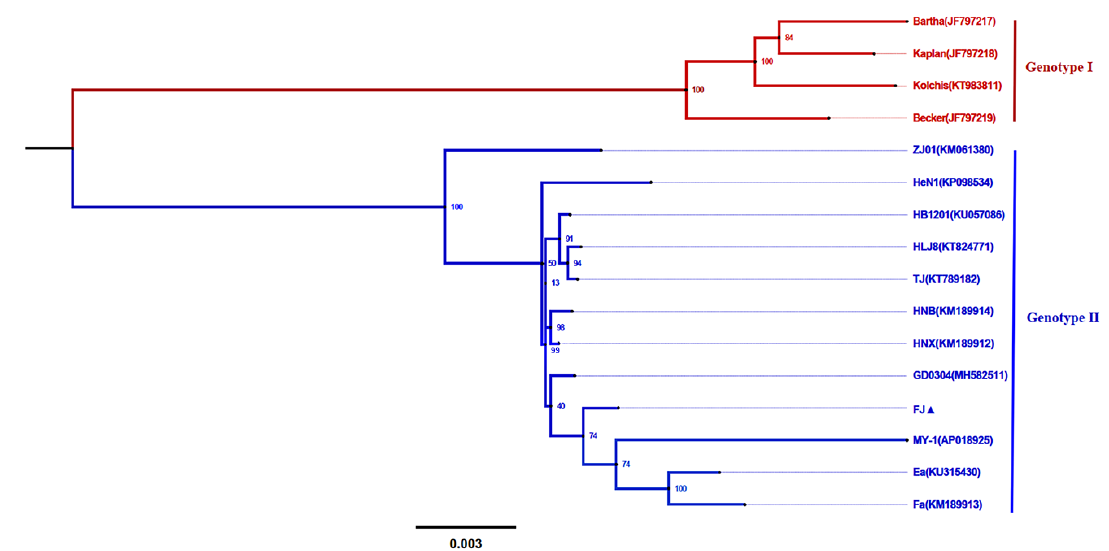
Figure 3. Phylogenetic analysis of the PRV complete genome sequences. The tree was constructed using the MEGA 7.0 software with the maximum likelihood method and 1000 bootstrap replicates. The bar and the number represent the genetic distance scale of these genes at this length is 0.003.